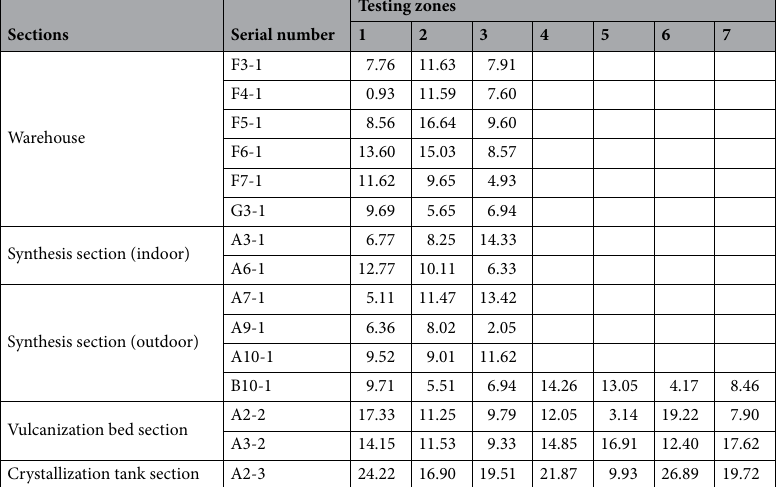
Table 2. Neutralization depth of concrete in the ammonium sulfate workshop.